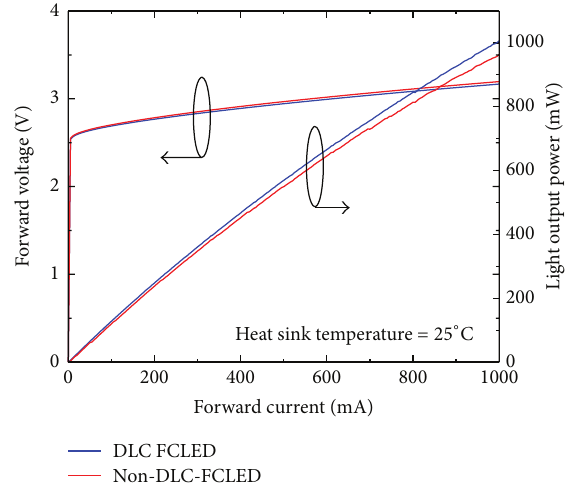
Figure 2: L-I-V characteristics of the DLC-VLED and non-DLC- VLED.